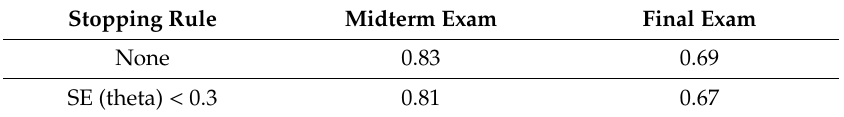
Table 4. Correlation between the estimated ability by CAFT and the sum scores of the exams.